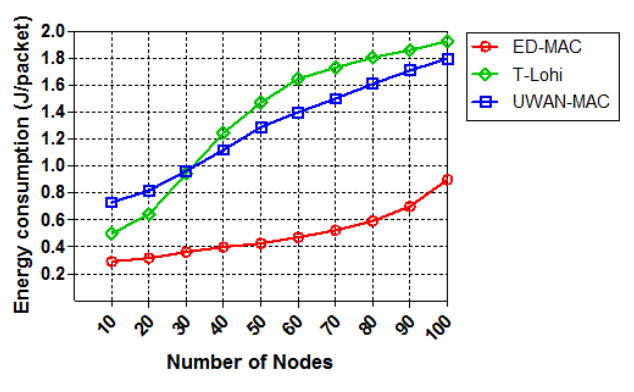
Figure 16. Energy consumption vs. node